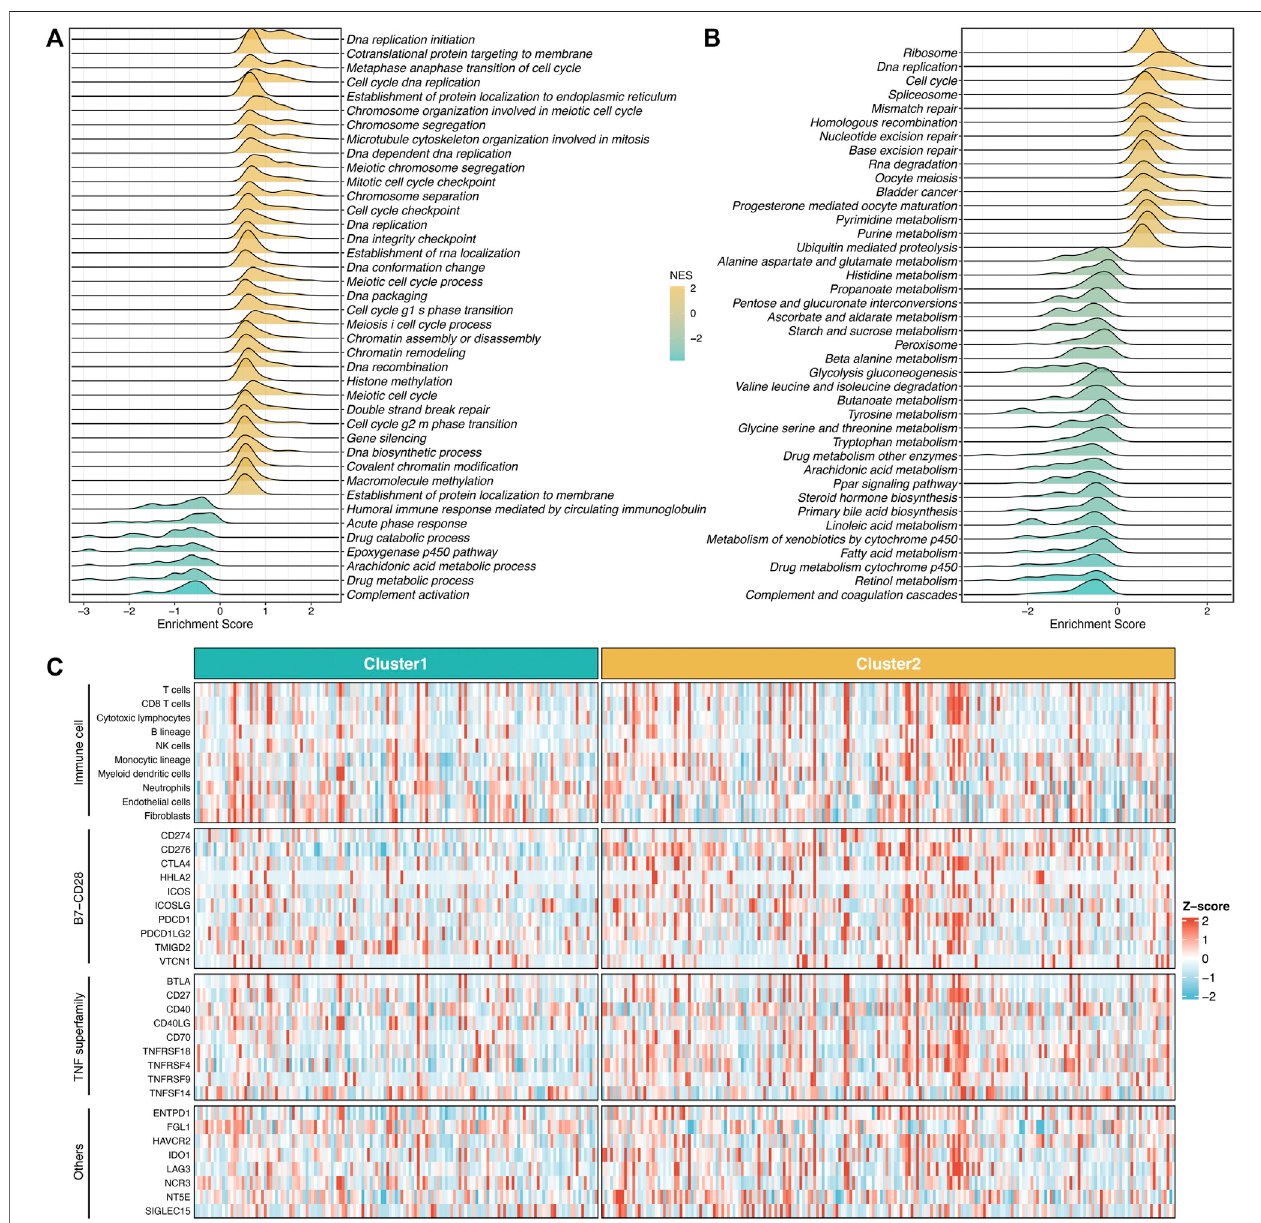
FIGURE3| Underlyingbiologicalprocessesofproliferation-relatedsubtypes. (A,B) GO (A) andKEGG (B) ofGSEAaccordingtotheproliferativesubtypes. (C) The immune correlation analysis between the two groups, including immune cell in fi ltrations and immune checkpoint.